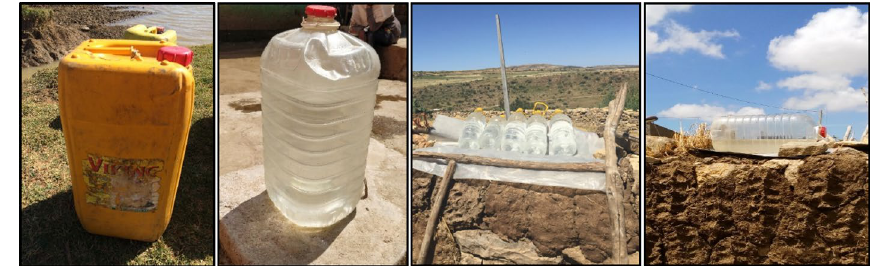
Figure 1. From left to right: Photographs of the standard opaque 25 L jerrycan used in Sub-Saharan Africa and 25 L PET TJC used for solar water disinfection and photographs of the 25 L PET TJC and 2 L PET bottles exposure on site in households of Tigray Region in